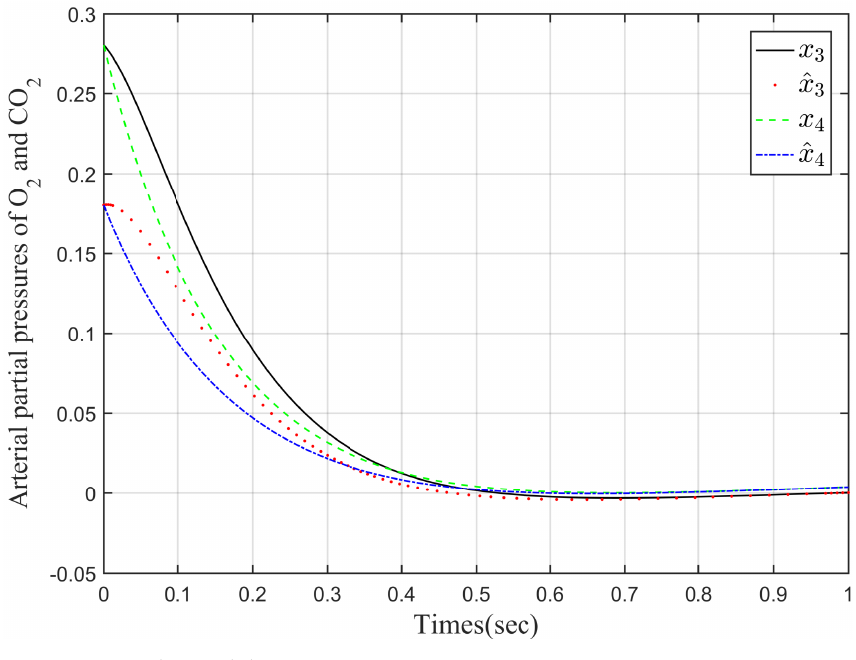
Figure 7. x 3 and x 4 and their estimations.